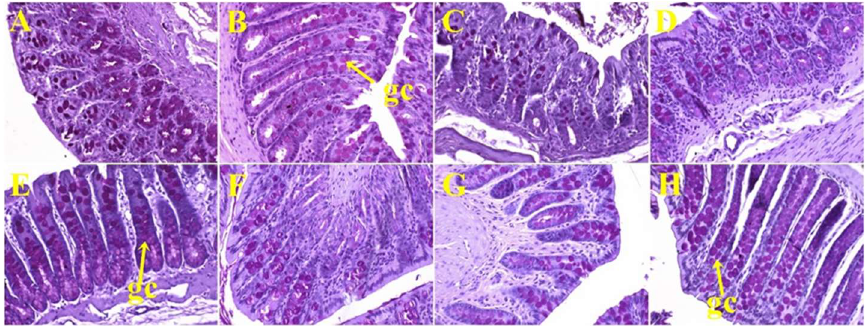
Figure 6. Periodic acid-Schiff staining of colon showing goblet cells (magnification ×20; shown by arrows) in corn starch diet-fed rats ( A ), corn starch diet-fed rats treated with whole linseed ( B ), corn starch diet-fed rats treated with defatted linseed ( C ), corn starch diet-fed rats treated with SDG ( D ), high-carbohydrate, high-fat diet-fed rats ( E ), high-carbohydrate, high-fat diet-fed rats treated with whole linseed ( F ), high-carbohydrate, high-fat diet-fed rats treated with defatted linseed ( G ), and high-carbohydrate, high-fat diet-fed rats treated with SDG ( H ). Goblet cells are marked as “gc”.